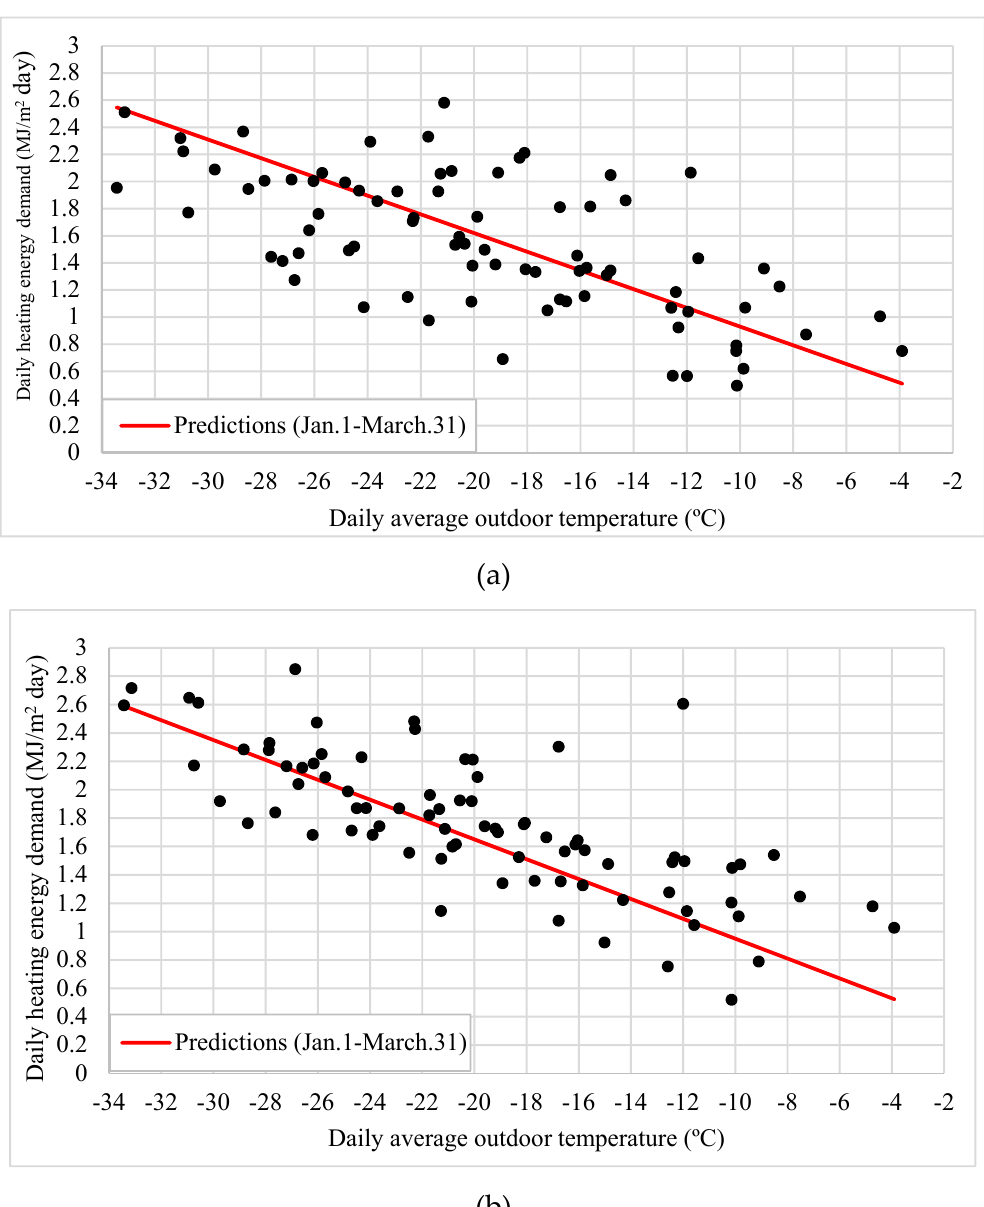
Figure 2. Measurements of daily total heating energy demand from January 1 to March 31, 2015 compared with the predictions of benchmarking models using static window technique: ( a ) house A and ( b ) house B.